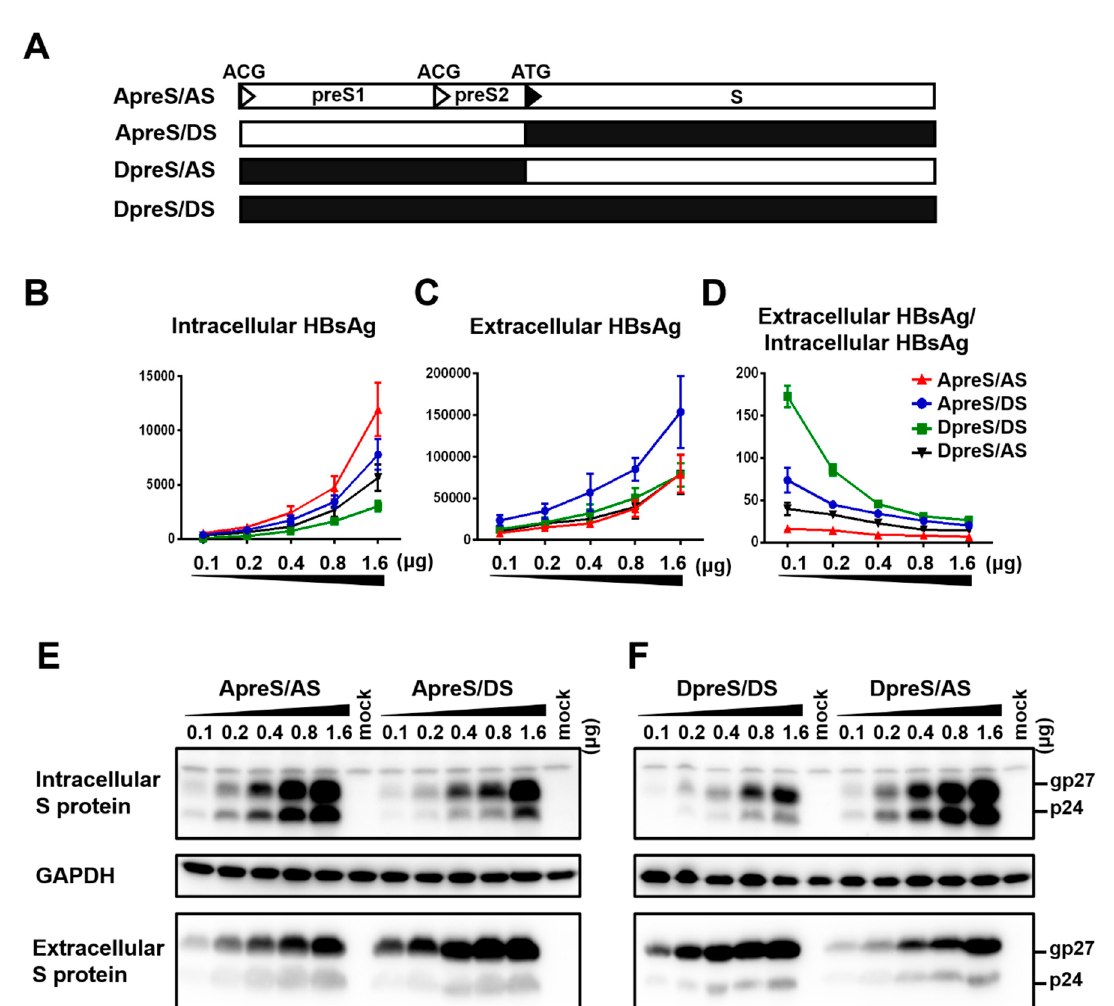
Figure 6. Chimeric 0.7 mer S protein constructs to dissect the relative contribution of the S region vs. upstream sequence on efficiencies of S protein expression and HBsAg secretion. ( A ) Schematic representation of the four types of 0.7 mer S protein construct: original geno5.4 (ApreS/AS) and geno1.2 (DpreS/DS), chimeric ApreS/DS and DpreS/AS. ( B – F ) Huh7 cells in 6-well plates were transfected with 0.1–1.6 μ g of the four types of 0.7 mer S protein construct. Cells and culture supernatant were harvested four days later. ( B , C ) Total amount of HBsAg (OD 450 ) from cell lysate ( B ) and culture supernatant ( C ). Data were averaged from three independent transfection experiments. ( D ) Calculated ratio of extracellular/intracellular HBsAg. ( E ) Comparison of ApreS/AS with ApreS/DS for intracellular and extracellular S protein. ( F ) Comparison of DpreS/DS with DpreS/AS for intracellular and extracellular S protein. For both panels, same volume of cell lysate or culture supernatant was used, and GAPDH served as loading control for cell lysate.